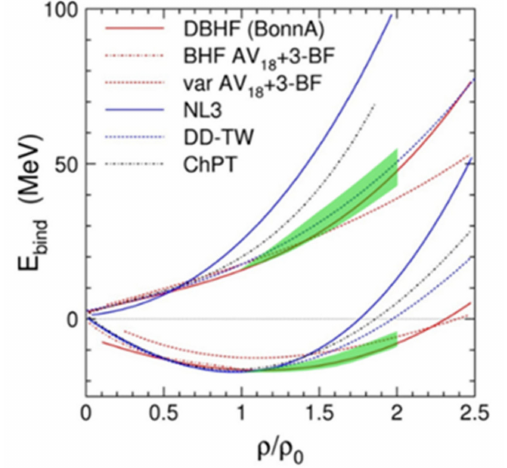
Figure 3. Binding energy versus baryon density. Lower set of curves: symmetric nuclear matter. Upper set of curves: neutron matter [18]. Green areas: analysis of experimental data obtained at GSI [11–15,17], see